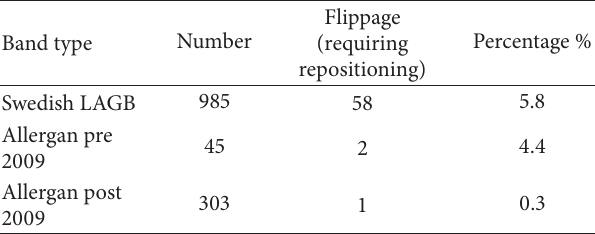
Table 1: Numbers of ports fixed with each technique and numbers of flippages requiring repositioning.